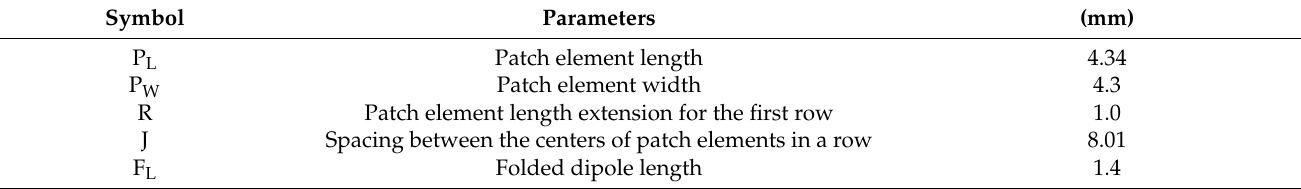
Figure 1. Final antenna ( a ) top view and ( b ) bottom view. Table 1. Optimized dimensions of the final proposed antenna.